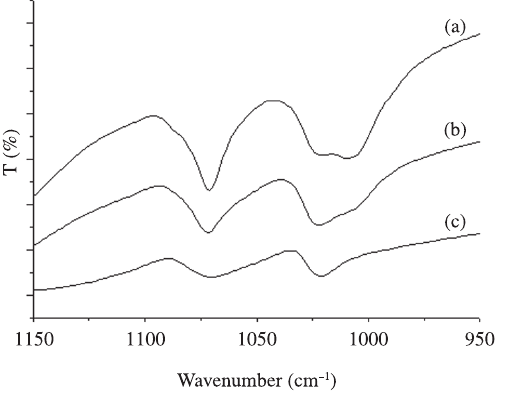
Figure 2. FTIR spectrum of the a highlighted region (a) SPAN 3.0, (b) SPAN 2.0 and (c) SPAN 1.5.